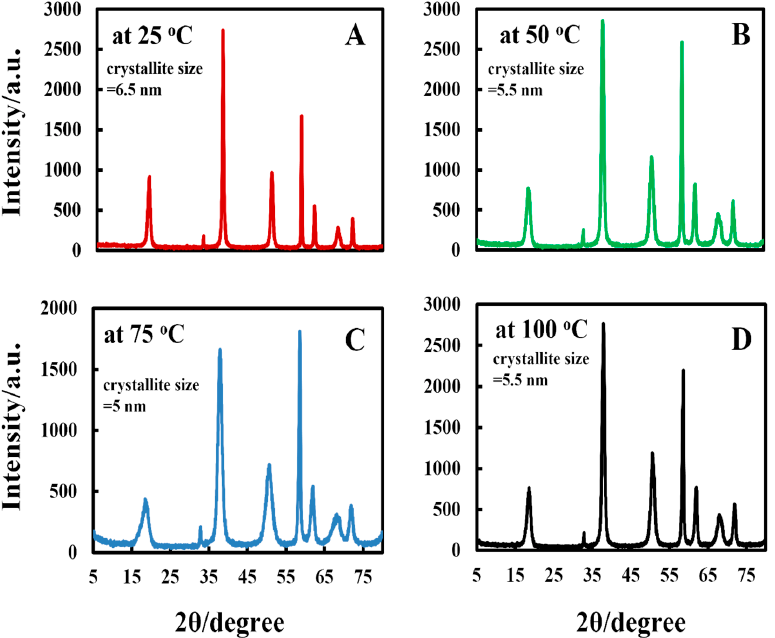
Figure 2. Comparison of the X-ray pattern of Mg(OH) 2 NPs precipitated at 25 °C ( A ), 50 °C ( B ), 75 °C ( C ), and 100 °C ( D ).